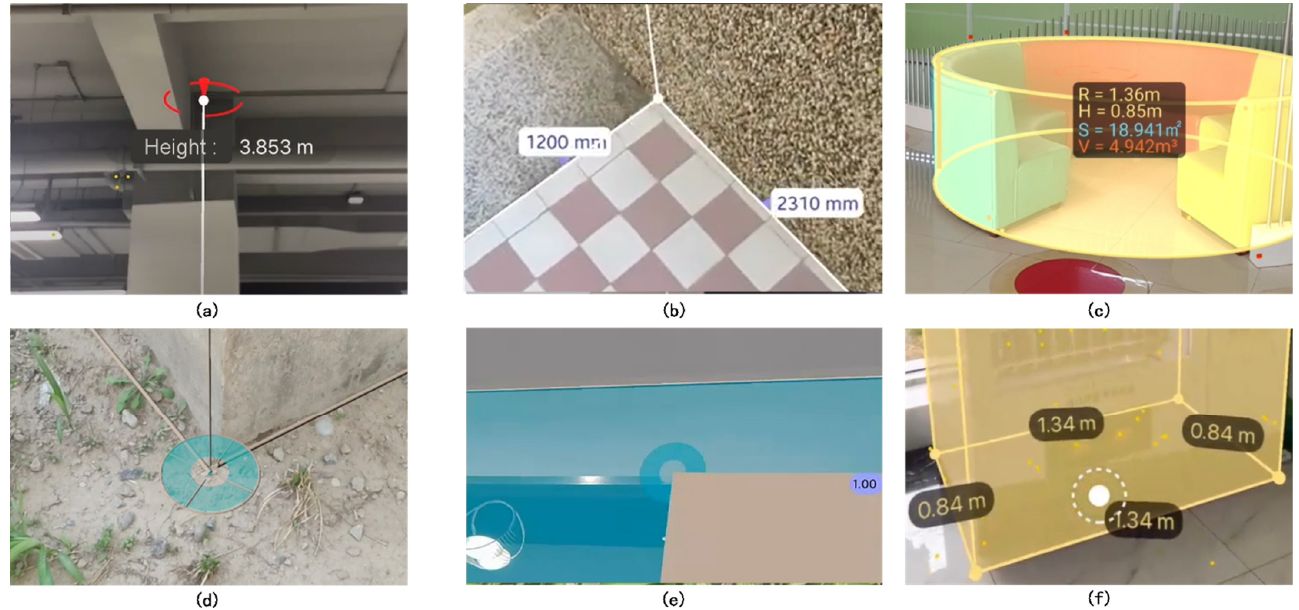
Figure 10. Modeling visual view of buildings in ARSnap: ( a ) Display the elevation line snap results of the real scene, ( b ) display the vector snap results of the virtual scene; ( c ) display the snap results of the irregular sofa; (d) display the plane snap results of the real scene; ( e ) display the wall snap results of the virtual scene; ( f ) display the snap results of the regular vending machine.